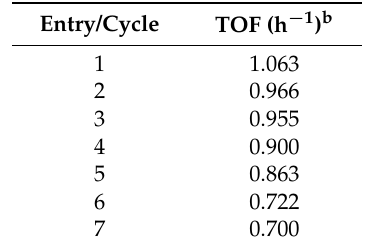
Table 3. Recycling of PdCl 2 (TPPTS) 2 supported on I a .